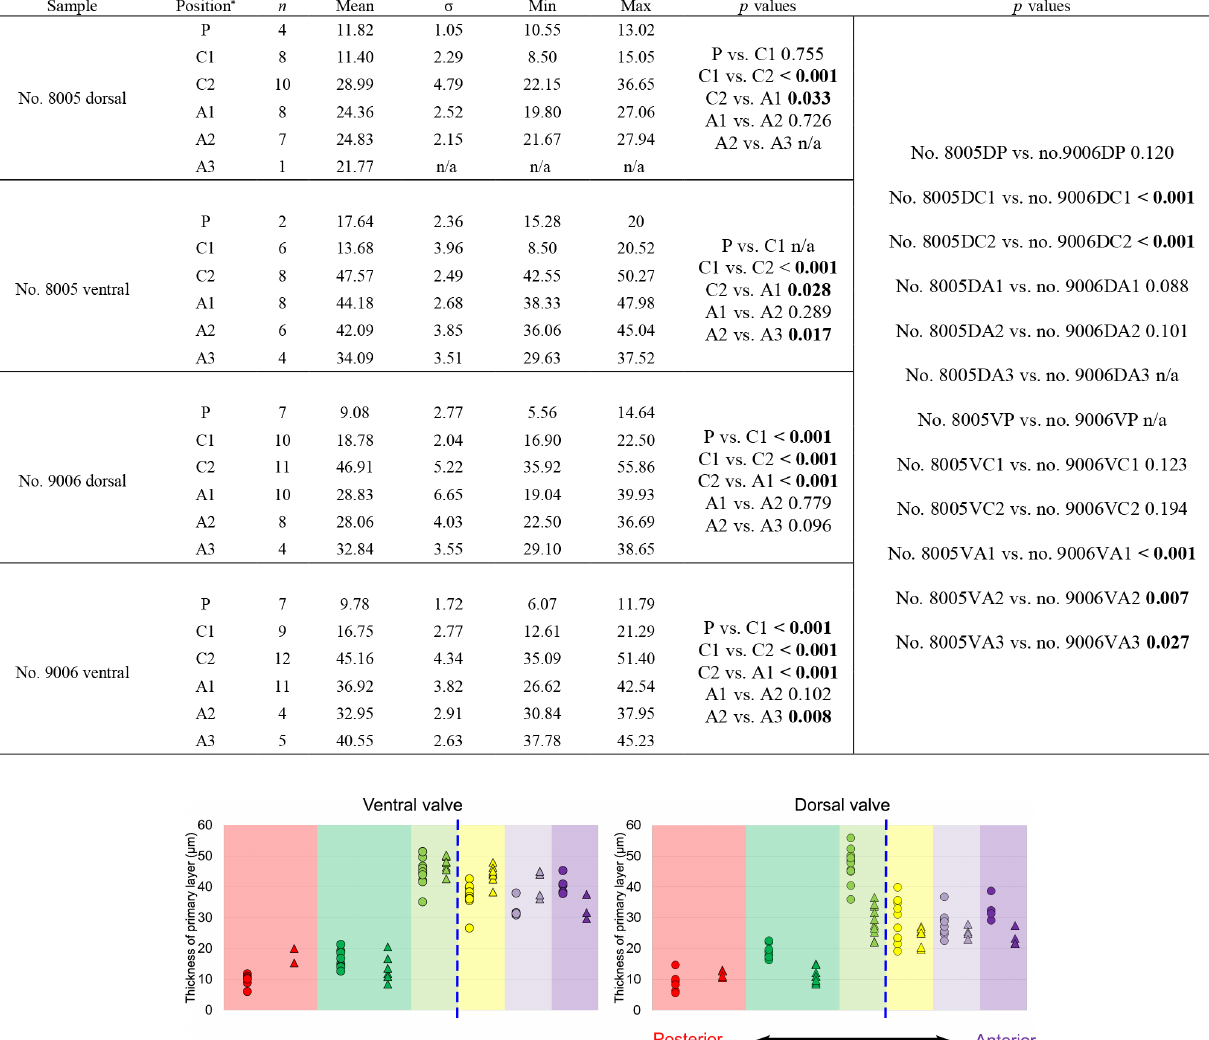
Table 5. Statistical comparison of thickness of the primary layer (µm) along the ontogenetic direction of both valves of specimens no. 8005 and no. 9006 before- and during-culturing . ∗ Position of zones before-culturing : P, C1, C2; during-culturing : A1, A2, A3 (cf. Fig. 6). n = number of measurements. Population standard deviation ( σ ) was calculated using the Excel STDEV.P function. Significant values ( p - value ≤ 0 . 05) are marked in bold. “n/a” stands for not applicable.